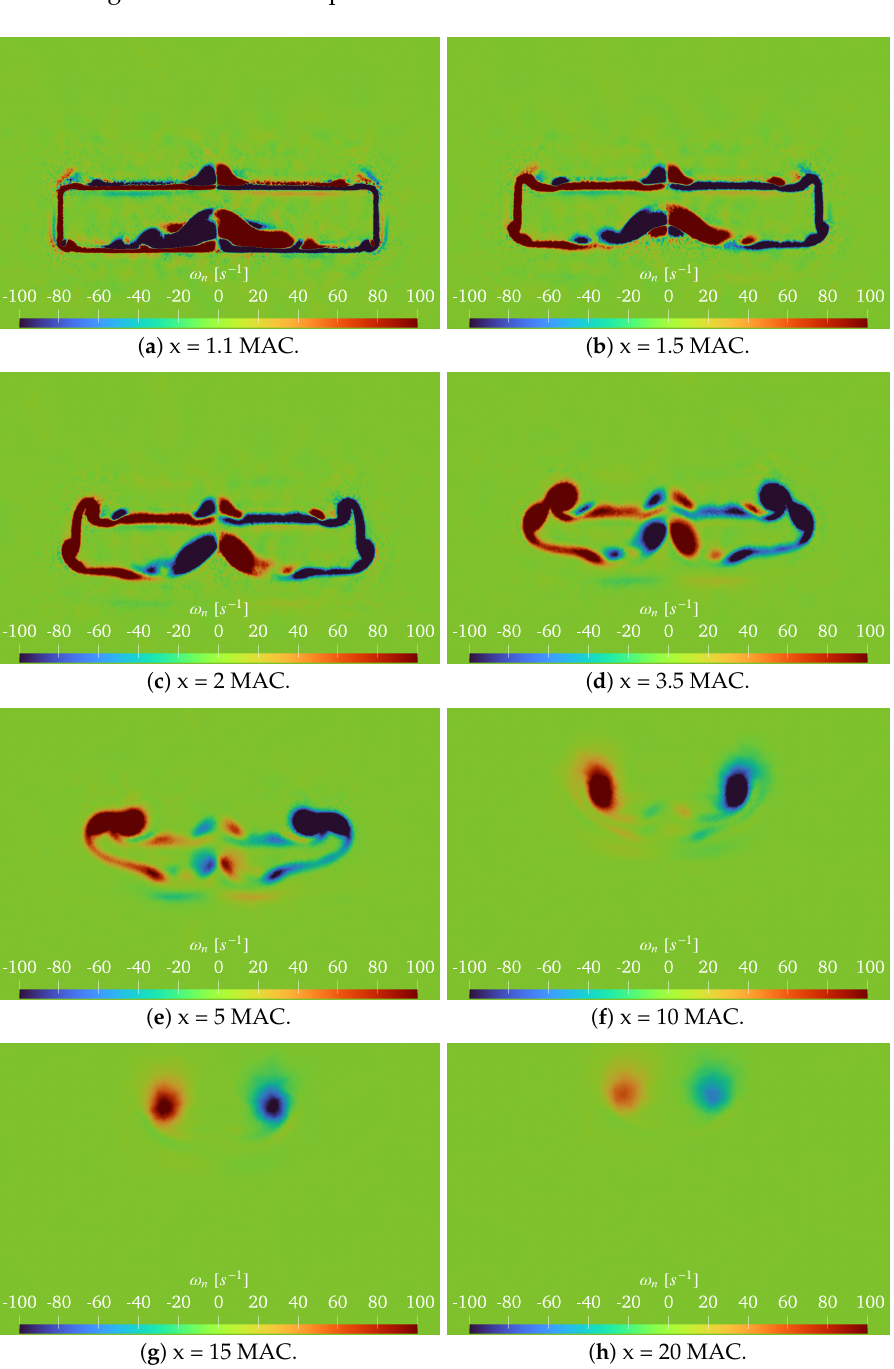
Figure 15. Vorticity contours for α = 18.5 ◦ at different positions downstream of the box wing